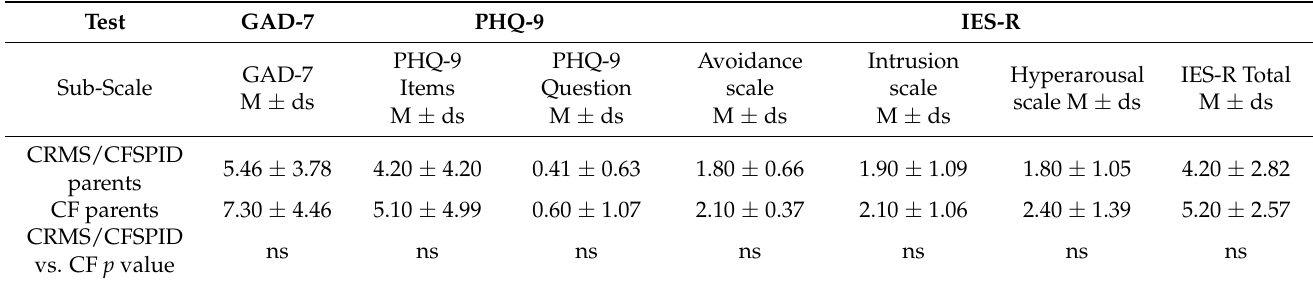
Table 1. Cumulative results of The GAD-7, PHQ-9, and IES-R tools in parents of children with CRMS/CFSPID vs parents of children with